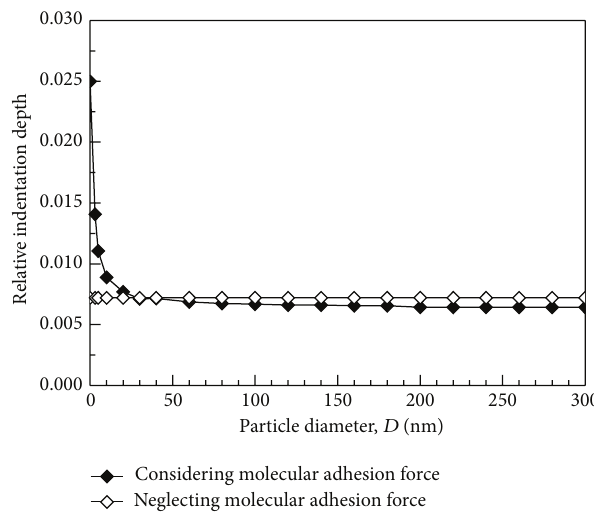
Figure 6: Comparison of relative indentation depth of abrasive